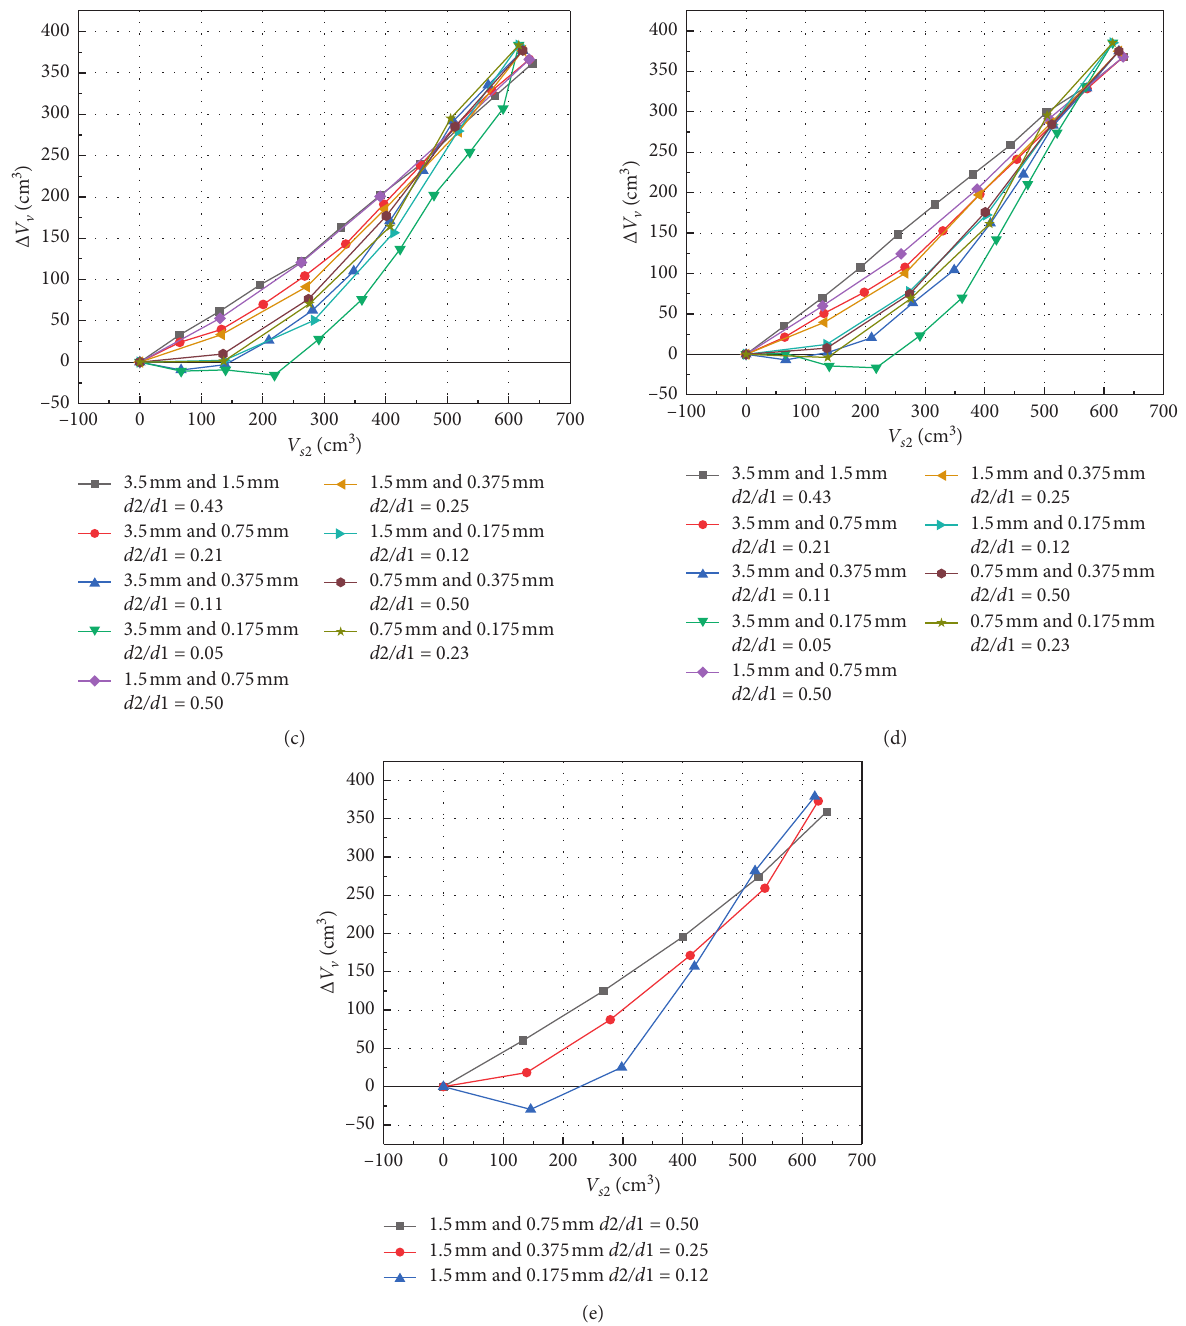
Figure 8: Variation of Void volume change with solid volume of fine particles: (a) B ; (b) C ; (c) DS; (d) NS; (e)